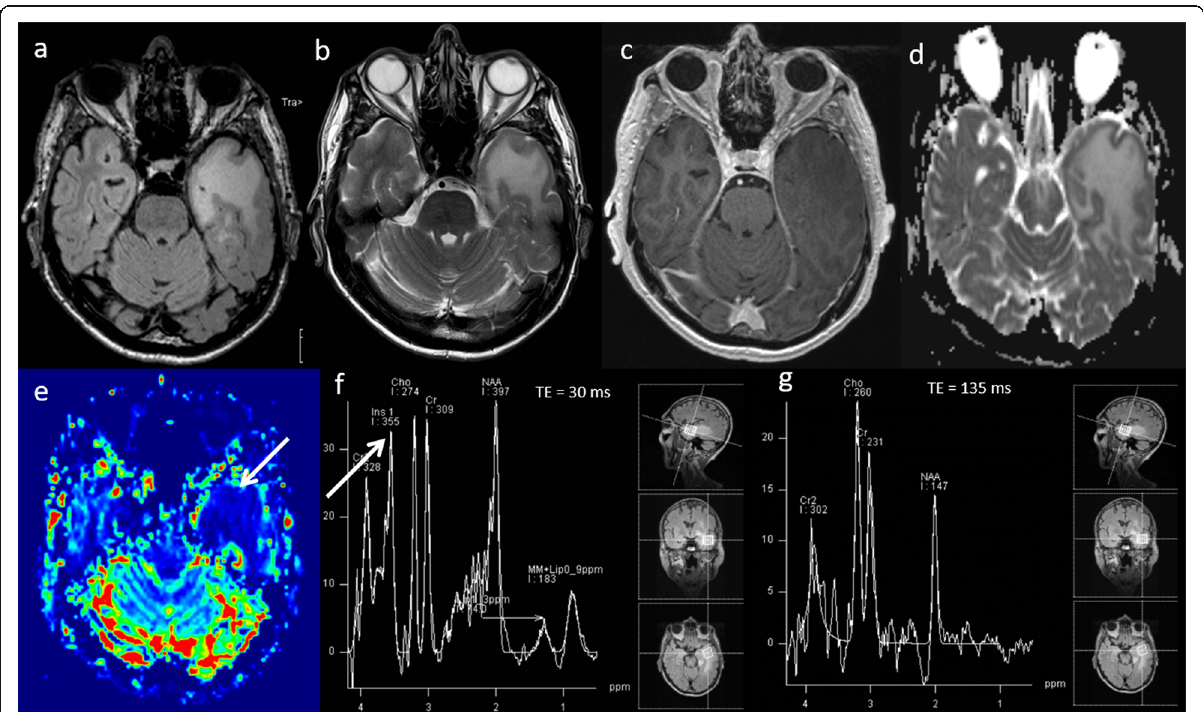
Fig. 3 Low-grade glioma. Conventional MRI: ( a ) FLAIR, ( b ) T2W and ( c ) post-contrast T1W sequences show a diffuse abnormality in the left temporal lobe without contrast enhancement. d ADC map shows high ADC throughout the lesion (1300 × 10 − 6 mm 2 s − 1 ). e PWI shows low perfusion throughout the lesion (arrow) compared to normal-appearing white matter, and ( f , g ) MRS (TE 30 ms) shows slightly raised Cho/Cr ratio (1.0), slightly low NAA/Cr (1.1) and very high mI/Cr ratio (0.9, arrow). Lipid or lactate peaks are not significantly elevated. Multiparametric MRI appearances suggest no evidence of dedifferentiation. Stable appearances have been seen on follow-up imaging for over five years, confirming the lesion ’ s low-grade